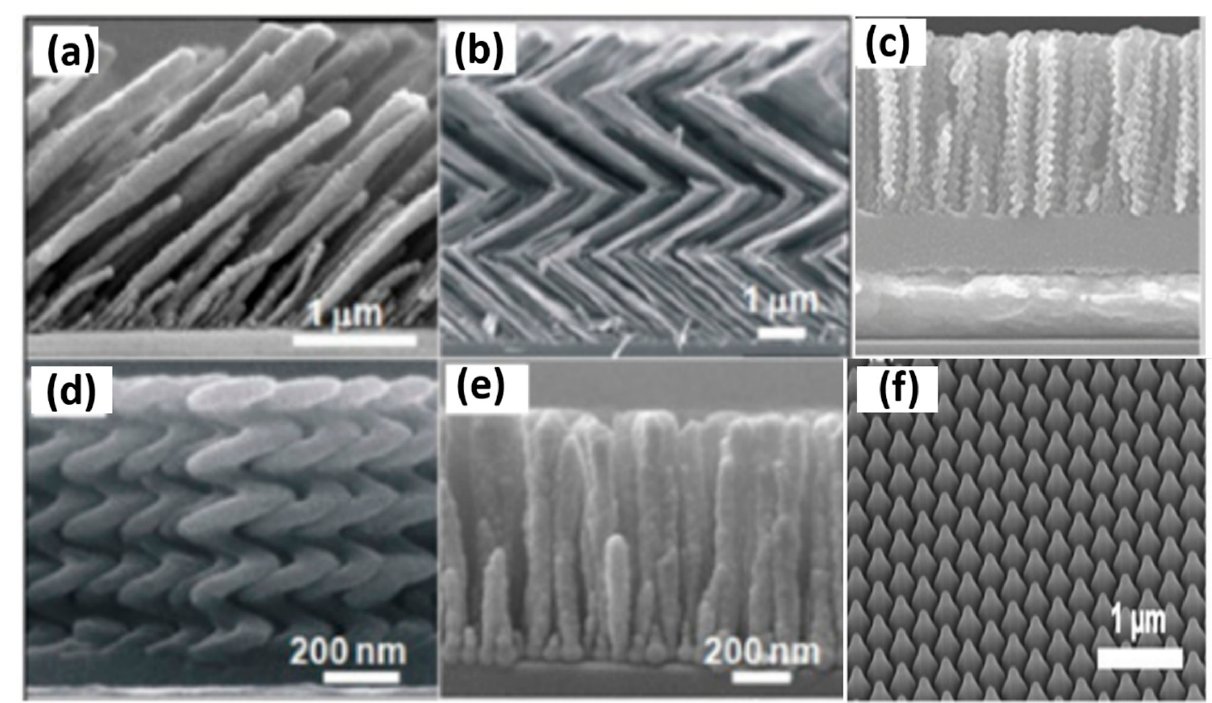
Figure 2. Different GLAD-structured thin films. ( a ) Slanted-post films; ( b ) zig-zag (chevron) films with 4 arms; ( c ) AgNR/SiO 2 SCL/SiO 2 /PCL/Ag multilayer substrates; ( d ) helical film; ( e ) vertical post structure (reproduced with permission from [67]); ( f ) 45° tilted top view of Au mushrooms (reproduced with permission from [68]).